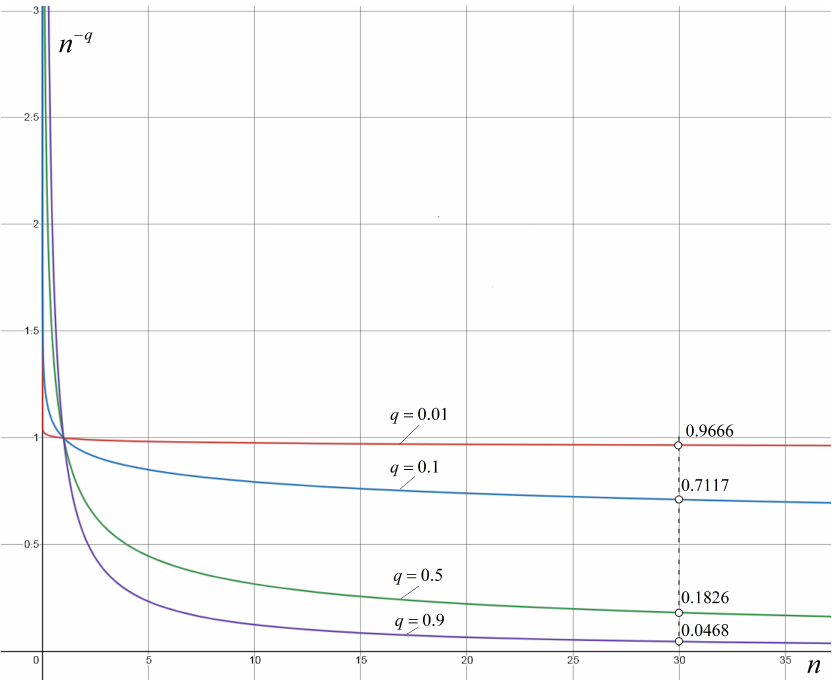
Figure 7. Graph of n − q for different values of q